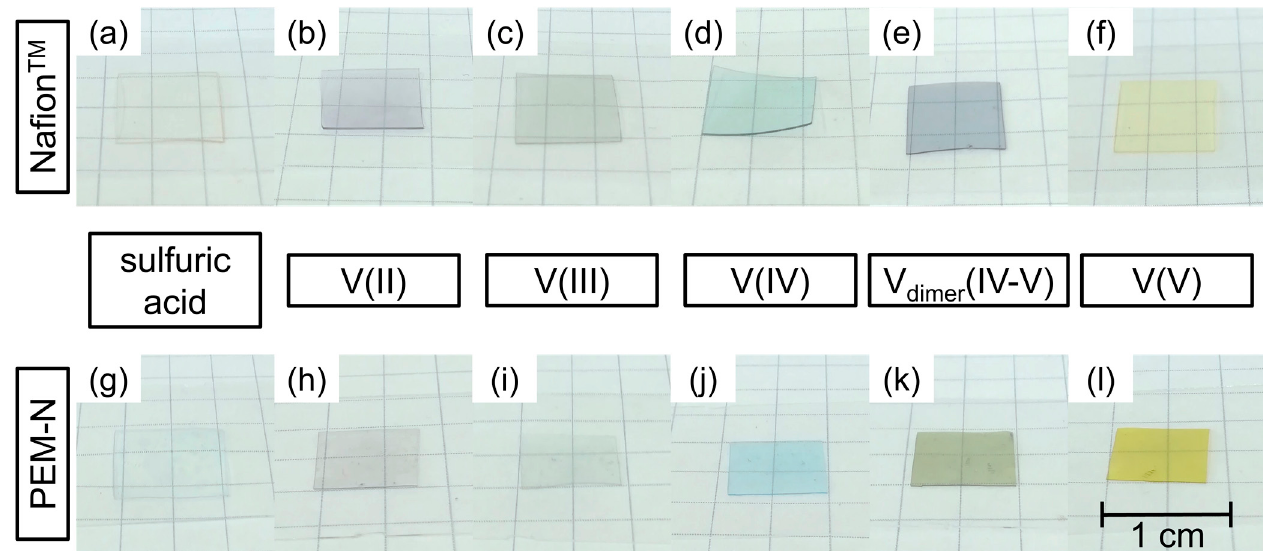
Figure 6. Sum spectra of untreated PVDF-based membrane, PVDF-based membrane before and after extraction (normalized on Rh L). Vertical reference lines: yellow: S K α , black: Rh L α and L β , red: K K α , green: Ca K α and K β , and blue: V K α and K β .